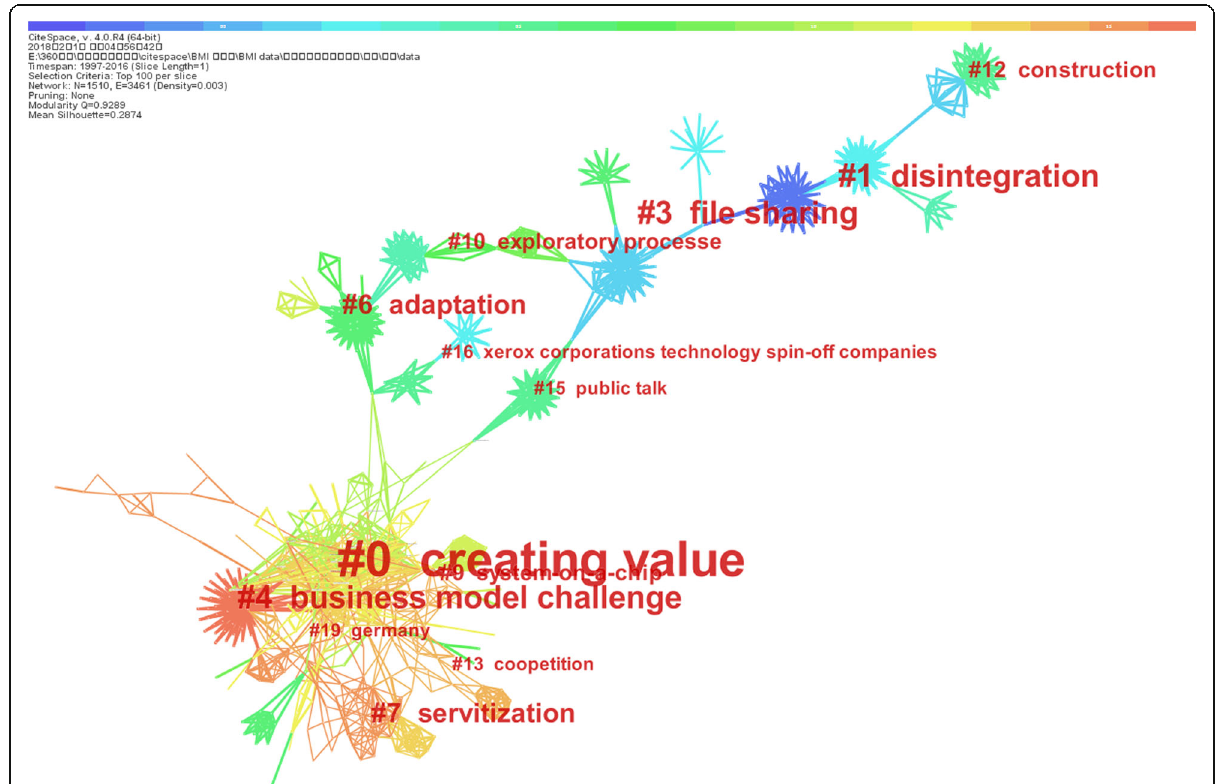
Fig. 2 The literature co-citation map of core dataset based on TFIDF algorithm